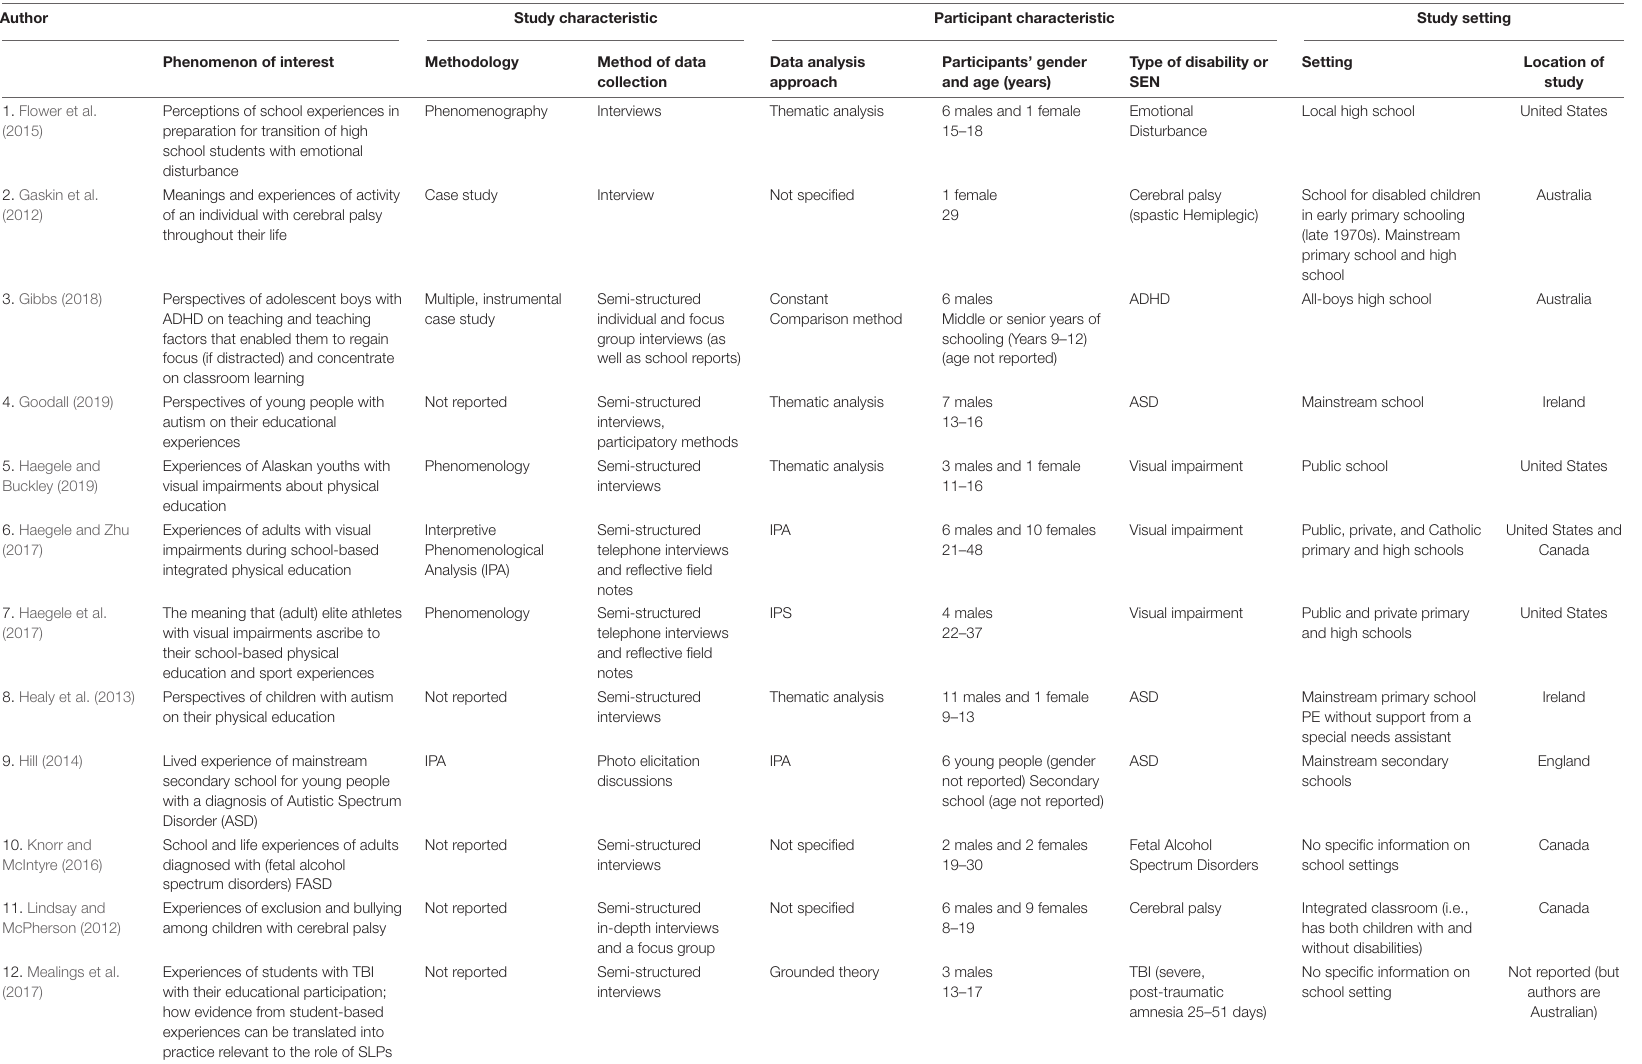
TABLE 3 | Main characteristics of the studies selected for data extraction and